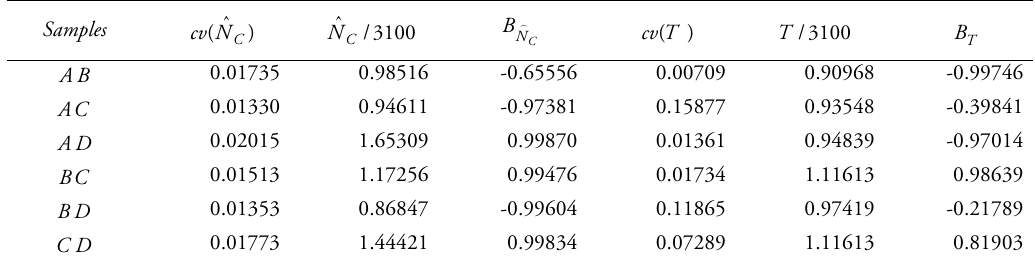
Comparison of the size estimator T